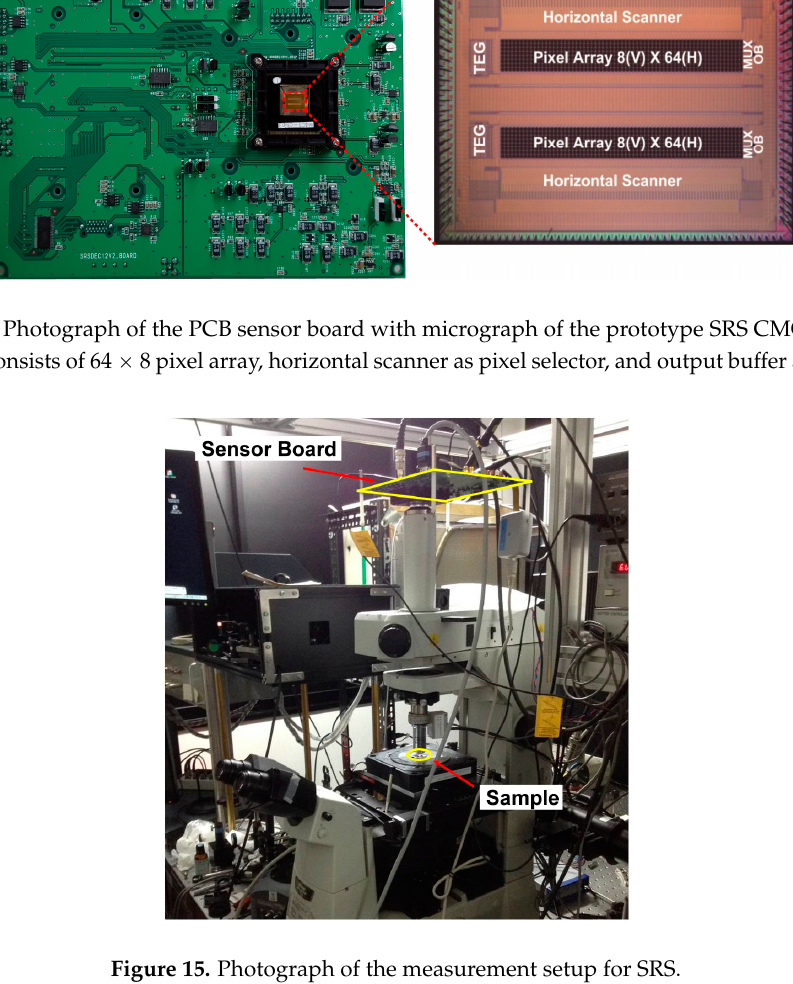
Figure 14. Photograph of the PCB sensor board with micrograph of the prototype SRS CMOS imager. The chip consists of 64 × 8 pixel array, horizontal scanner as pixel selector, and output buffer amplifiers.